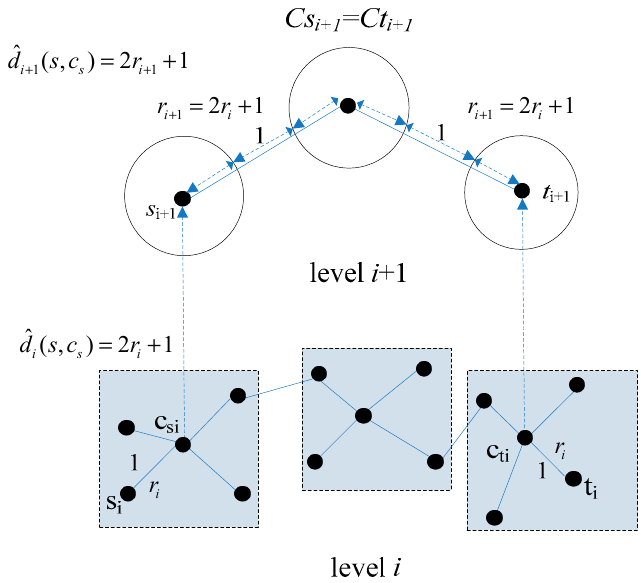
Figure 3. Illustration of approximate distance r i .